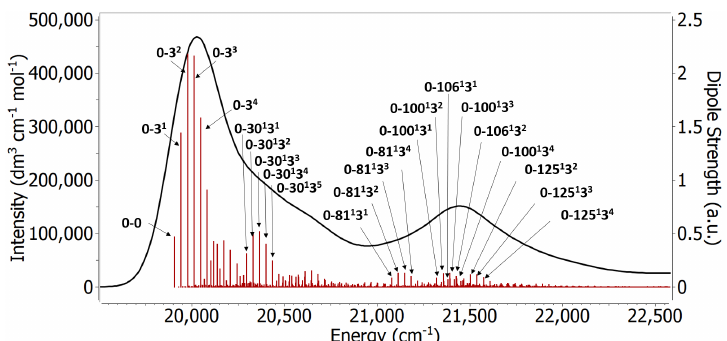
Figure 8. The vibronic spectrum obtained from structures optimized with ω B97XD/Def2SVP in gas phase at 0 K using the AH approach. The red sticks correspond to the vibrational excitations. The labels on the sticks are selected